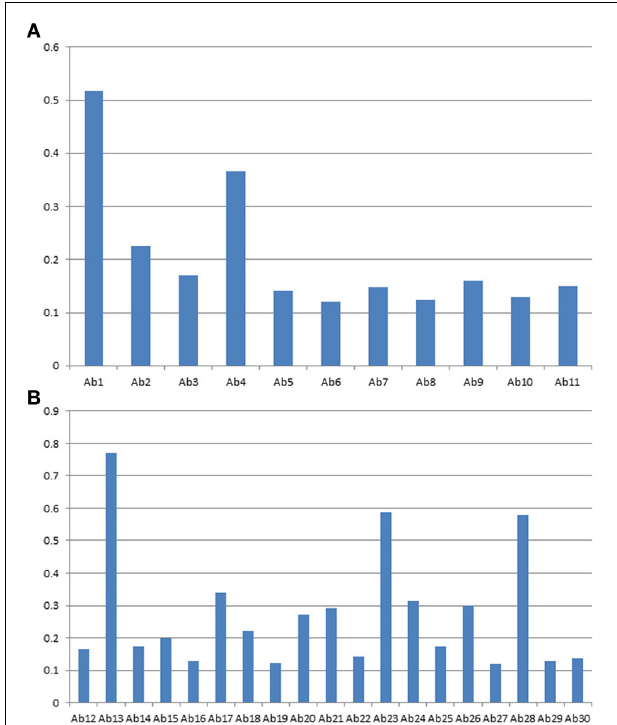
FIGURE 6 | (A) Avastin variable region profile analyzed with antibody array ELISA. A sequence-specificset of antibodies against Avastin variable region were used for the analysis of surface epitope exposure. (B) Avastin constant region profile analyzed with antibody array ELISA. The common set of antibodies designed against the Herceptin constant region were used for the analysis of surface epitope exposure.